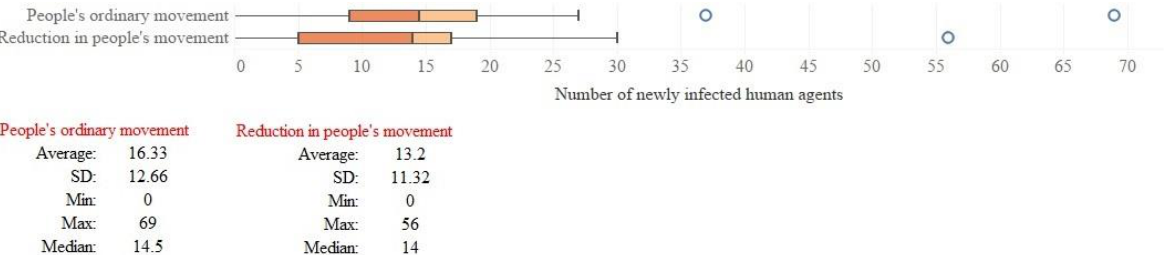
Figure 9. The number of newly infected human agents in two modes of considering people’s ordi- nary movement as well as a reduction in people’s movement; each agent is a representative of 100 people.